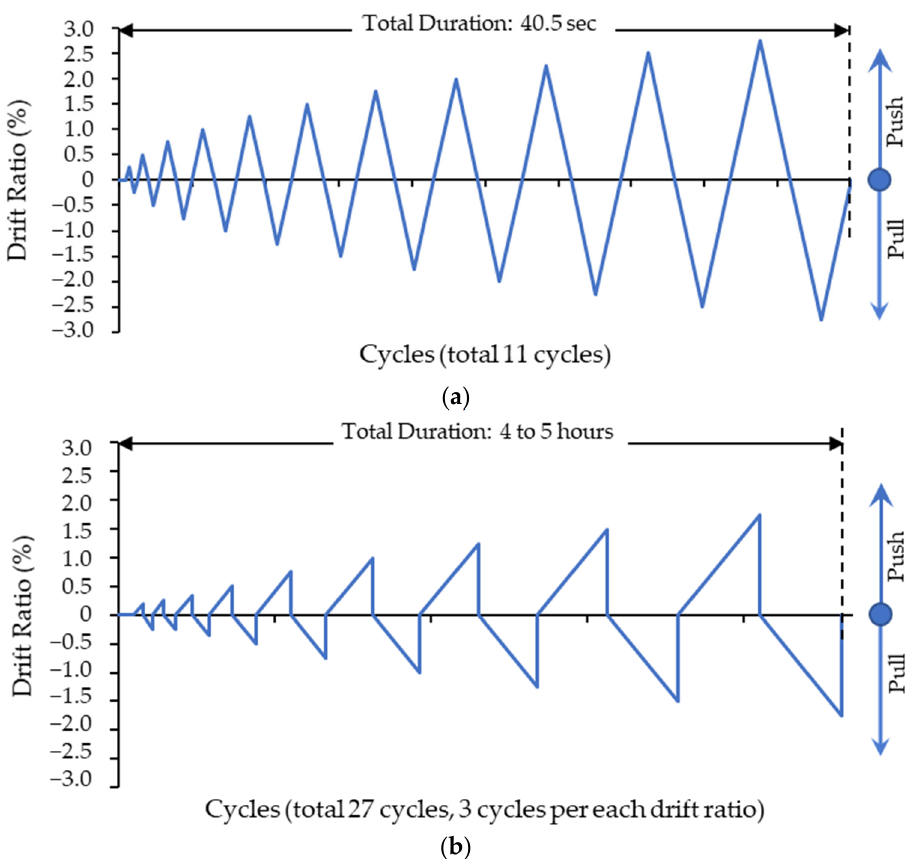
Figure 10. Loading scheme: ( a ) Analytical model; ( b ) tested specimen.